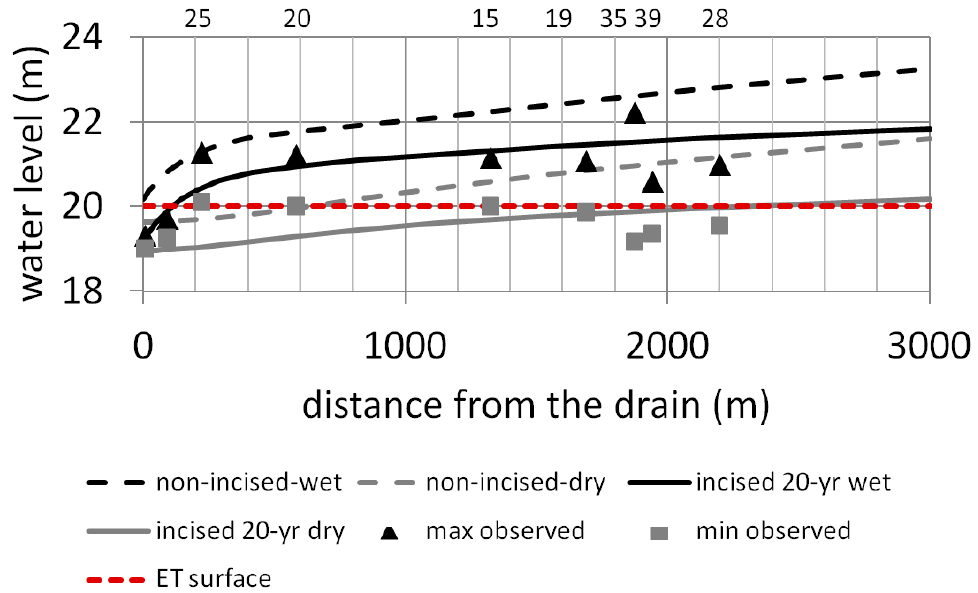
Figure 10. Model results for the water table elevation before ditch incision (steady state) and 20 years after 1 m of incision, with K = 7 m/day and specific yield = 0.12. The average elevation at the base of the sandy sediments in the study area lies at 302 m. Observation well numbers are shown at the top, with D10 and MIDPT unlabeled on the left.